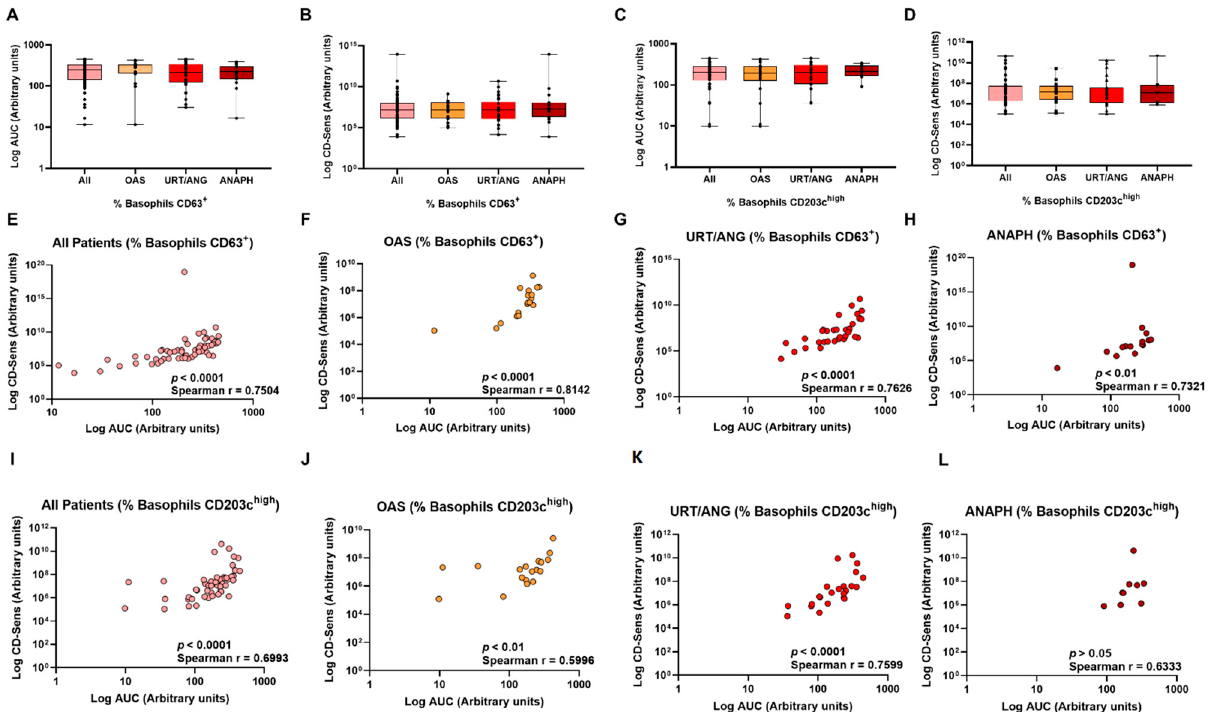
Figure 6. AUC and CD-Sens parameters do not distinguish clinical severity groups. ( A – D ) Comparisons of values of AUC and CD-Sens obtained from %CD63 + and %CD203c high parameters. No differences were found in these BAT parameters among compared groups. Correlations between AUC and CD-Sens from %CD63 + ( E – H ) and %CD203c high ( I – L ) were performed, showing positive significant correlations in the clinical groups. ANAPH, anaphylaxis; OAS, oral allergy syndrome; URT/ANG, urticaria/angioedema.